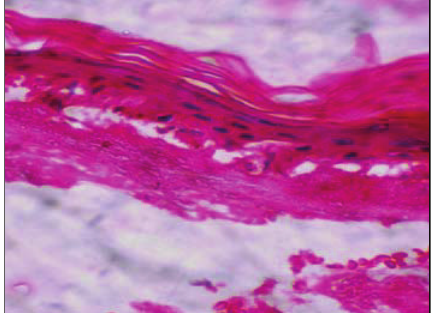
Figure 2: Acantholytic cells in Tzanck smear ( arrows ) (Giemsa, × 40). Figure 3: Histopathology of skin lesion shows mild spongiosis, edema, and predominantly subepidermal bulla and no inflamma- tory cell infiltrate (H&E, ×